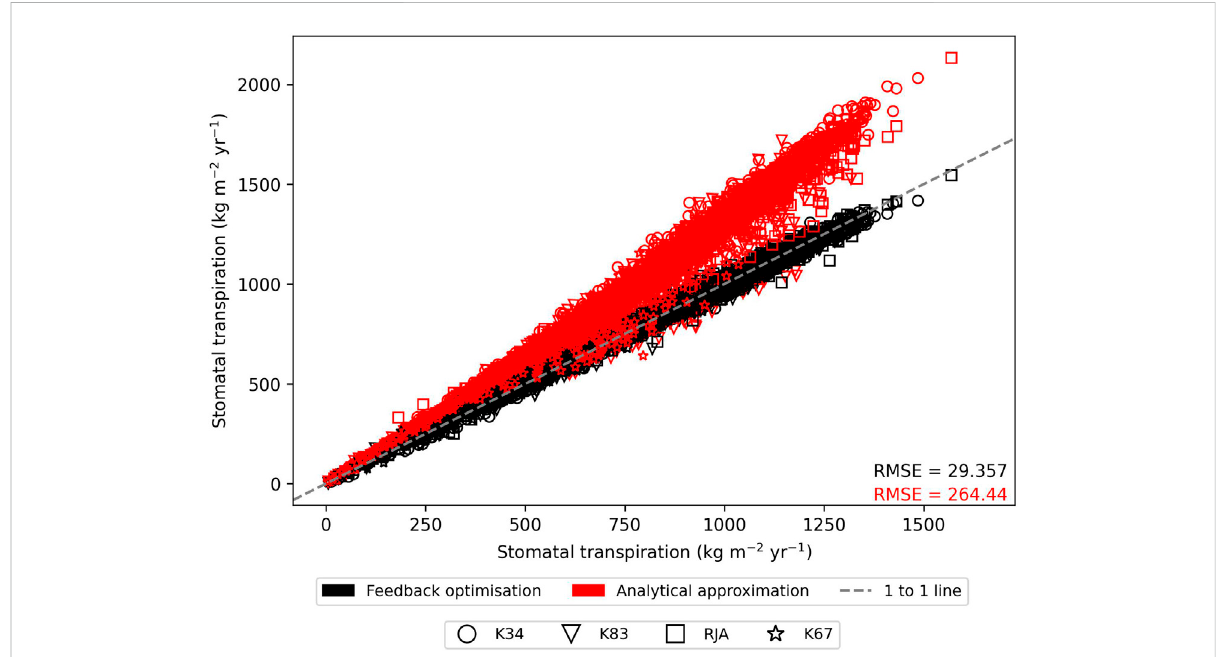
acrosssimulationsfromfoursitesintheAmazonrainforest.ThesitesareLBA-K34:ReservaCuieiras,ManausBrazil;LBA-K83:TapajosNationalforest, Santarem Brazil; LBA-RJA: Reserva Jaru; LBA-K67: Tapajos National forest, Santarem Brazil. Root mean square error (RMSE) values between values predicted by the numerical version and the two other versions across all simulations are